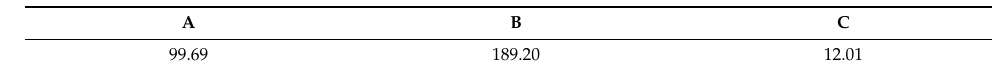
Table 9. Voce constitutive equation coefficients of material 5754O.